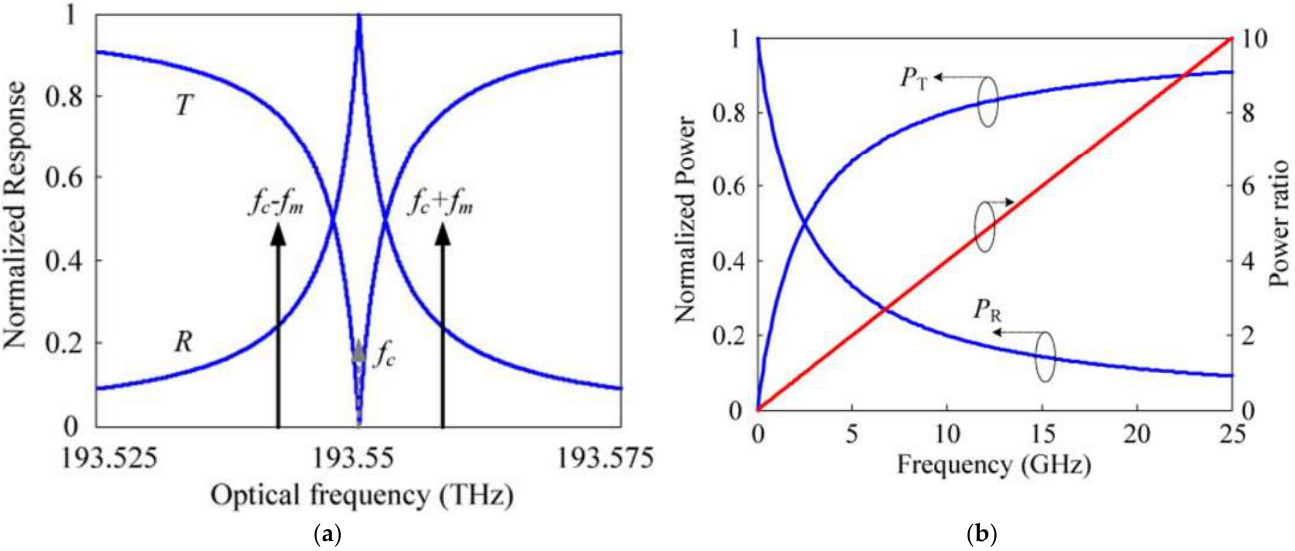
Figure 5. Calculated results for a concave FBG: ( a ) Dependence of the detected optical power and the power ratio on the microwave frequency; ( b ) Frequency response of the special FBG with two slopes that are inversely proportional to the optical frequency (Reprinted with permission from Ref [23]. Copyright 2011, IEEE).